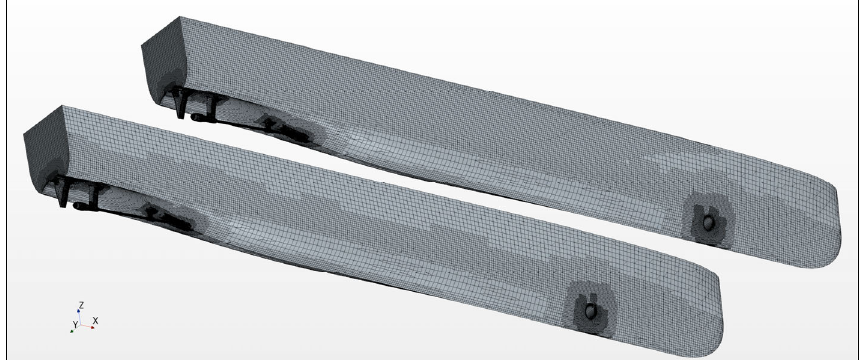
Figure 5. Grid structure on the fully ‐ appended Stavanger Demonstrator.